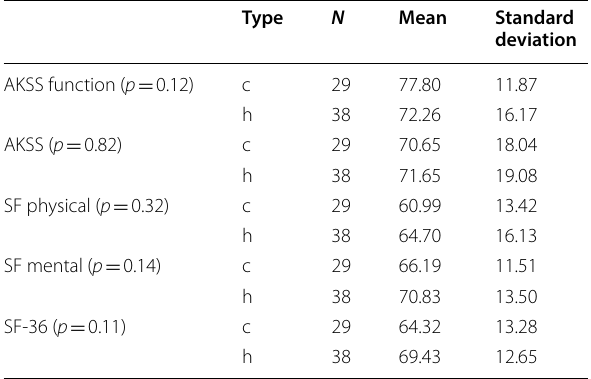
Table 1 AKSS and SF-36 results for the cemented (c) and hybrid (h) arthroplasties Type